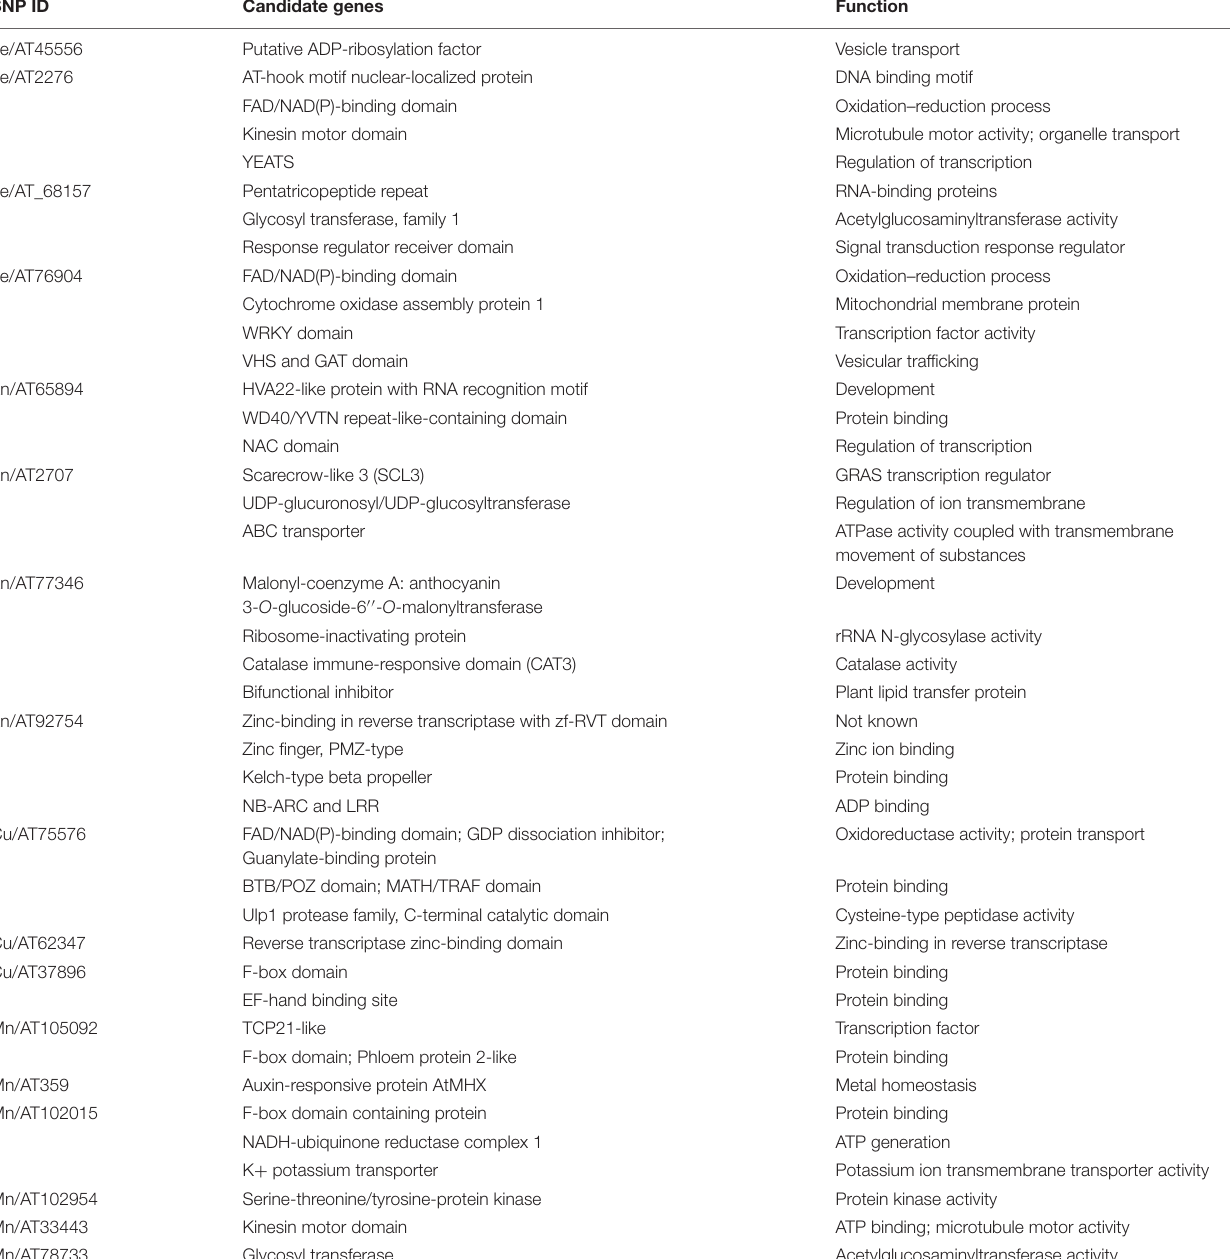
TABLE 4 | Candidate gene predicted in genomic regions harboring grain micronutrient marker trait